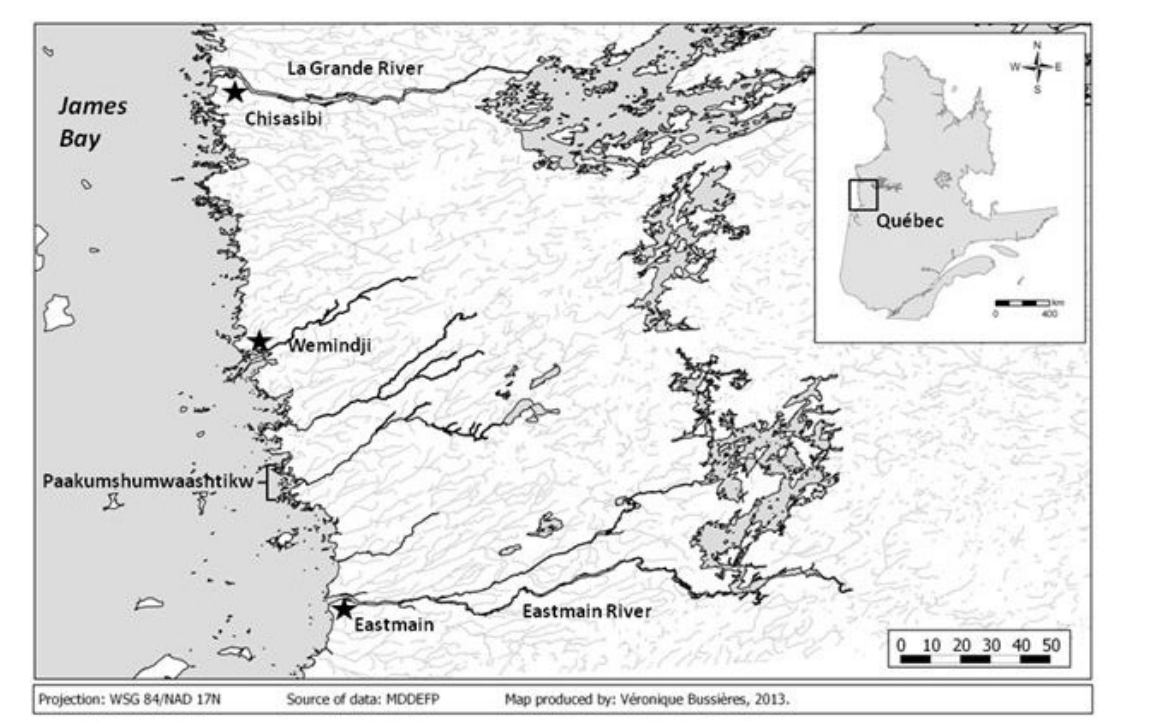
Fig. 1 . Map of eastern Eeyou Istchee, northern Québec, Canada.